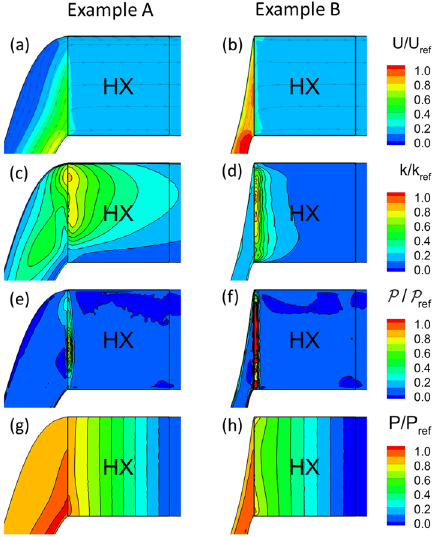
Figure 20. Aerodynamic comparison of two extreme manifold designs in terms of velocity ( a , b ), TKE ( c – d ), production of TKE ( e – f ), and total pressure ( g – h ).